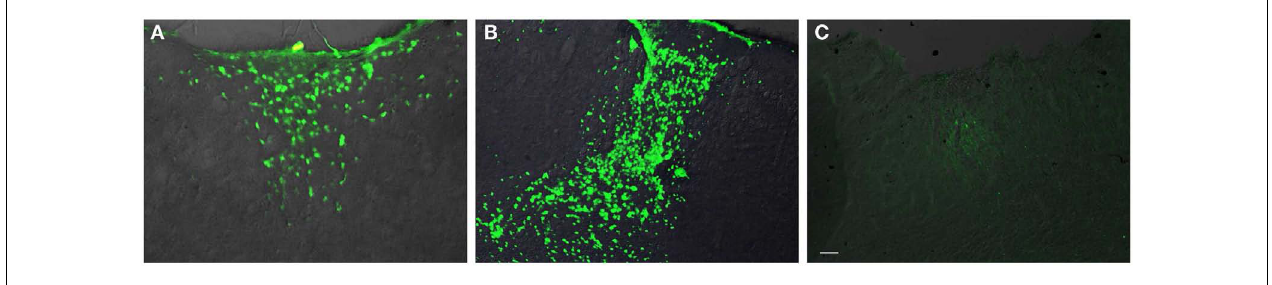
timepoint. By 7days post-FPI (C) , the number of degenerating cells is considerably less (and was non-existent in most of the sections examined) than the 1- or 3-day post-FPI timepoints. Scale bar in (C) = 50 µ m for all